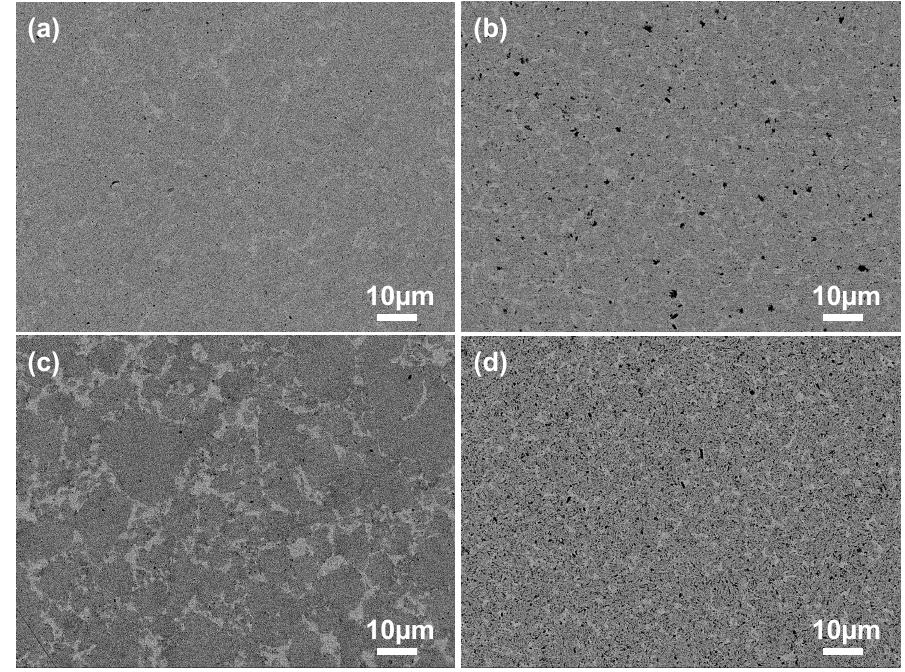
Figure 4. SEM images of Cu–TiH2–C and Cu–Ti–C nanocomposites Spark Plasma Sintered at 1000 °C: